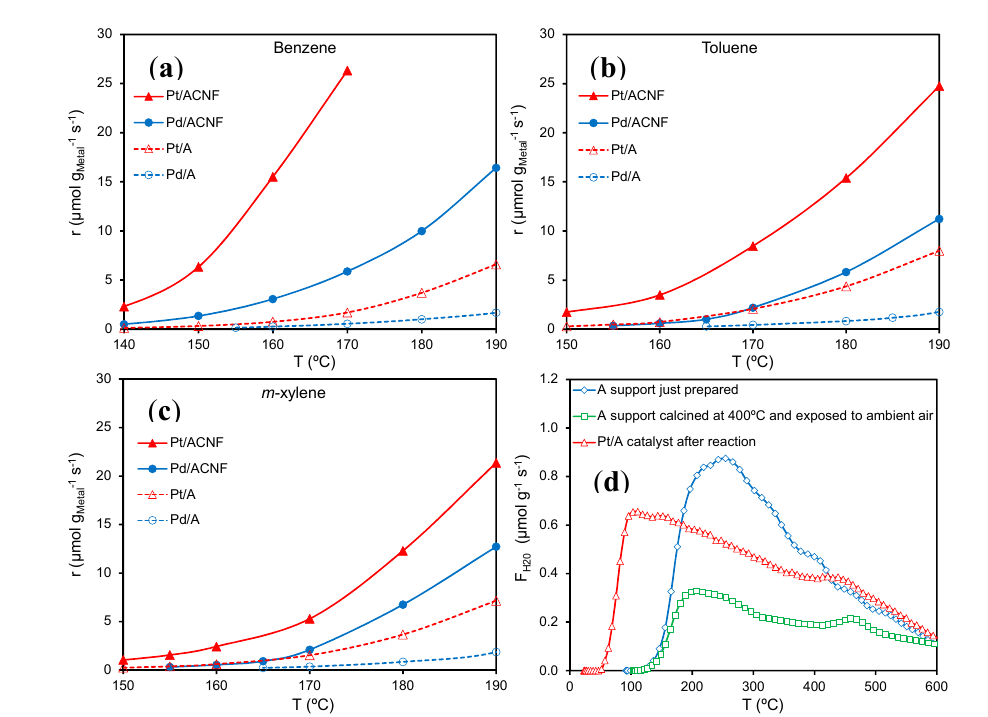
Figure 15. Catalytic activity of the catalysts (normalized per gram of Pt or Pd) as a function of the reaction temperature: ( a ) combustion of benzene, ( b ) combustion of toluene and ( c ) combustion of m -xylene. ( d ) Water desorption profiles obtained by TPD. Figures adapted with permission from [63]. Copyright 2006,